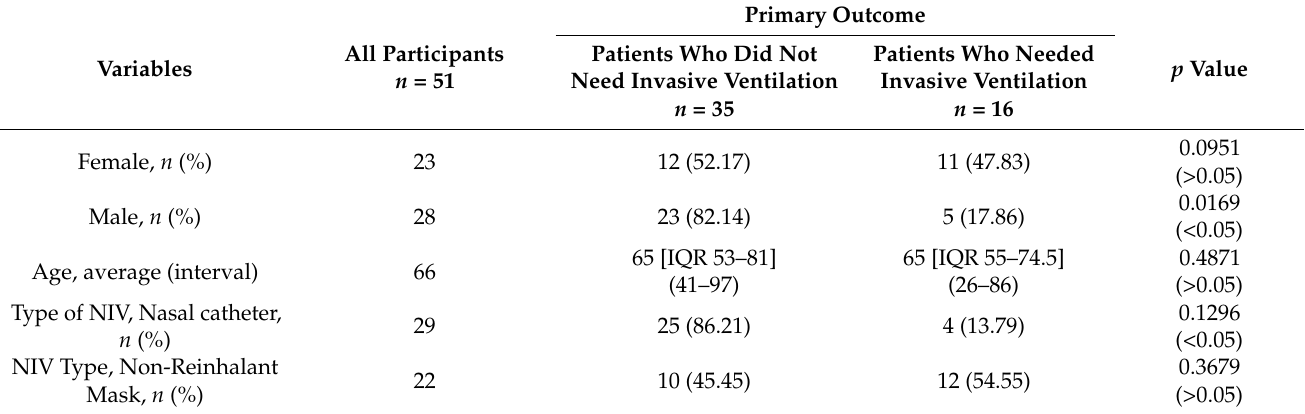
Table 1. Characteristics of the study patients ( n = 51), comparing patients who needed invasive ventilation ( n = 16) and those who did not need this intervention ( n =